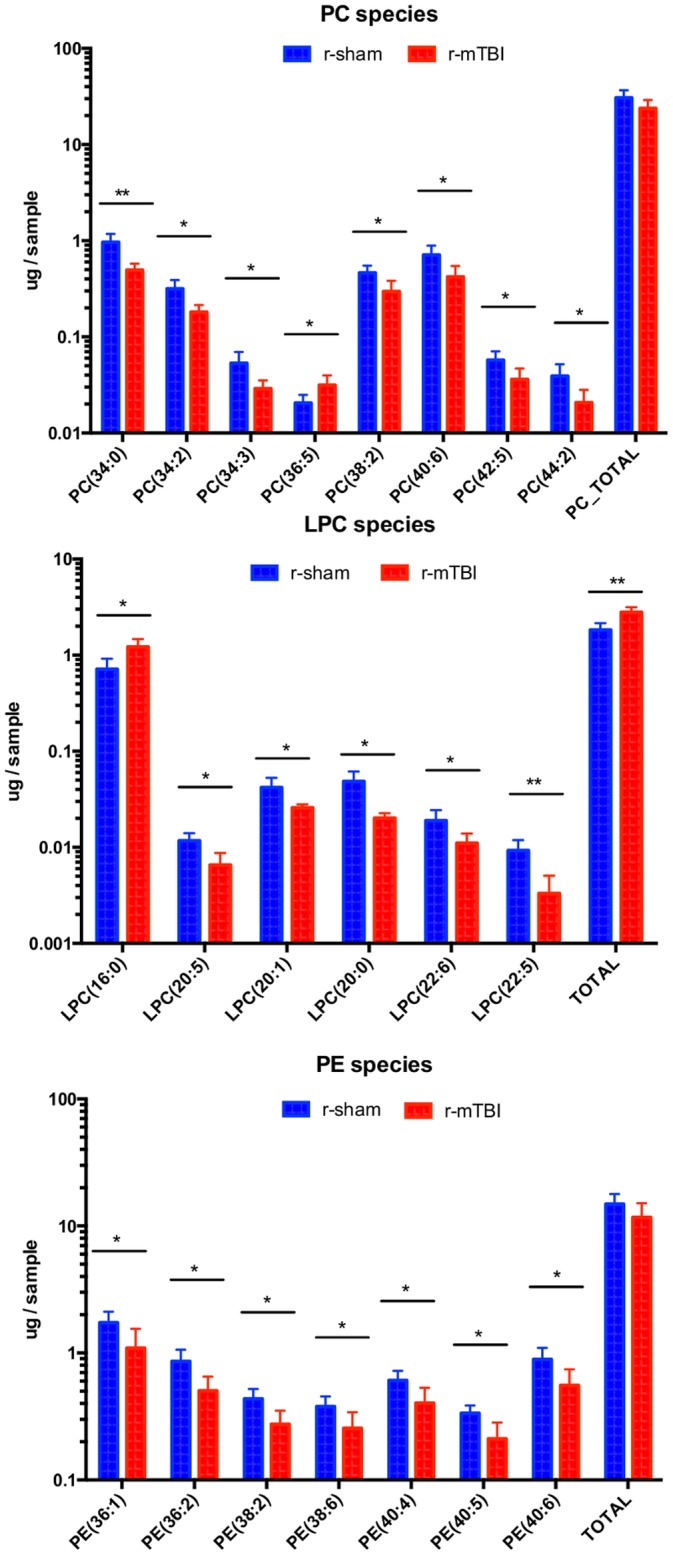
Quantitative assessment of phosphatidylcholine (PC), lysophosphatidylcholine (LPC) and lysophosphatidylethganolamine (LPE) in optic nerve samples at 3 weeks after injury.Significant changes in individual molecular species together with changes in the total amount of lipids in the respective classes are shown. Upper panel—changes in PC, middle panel—changes in LPC, lower panel—changes in LPE species. Color coding and asterisk association same as in Fig 5.